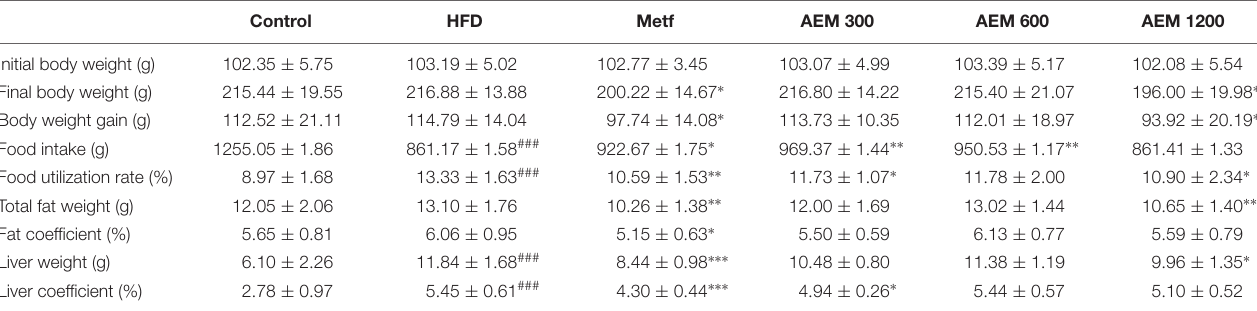
TABLE 2 | Effects of aqueous extract of black maca (AEM) and metformin on body weight, food intake, food utilization, and fat and liver coefficients in golden